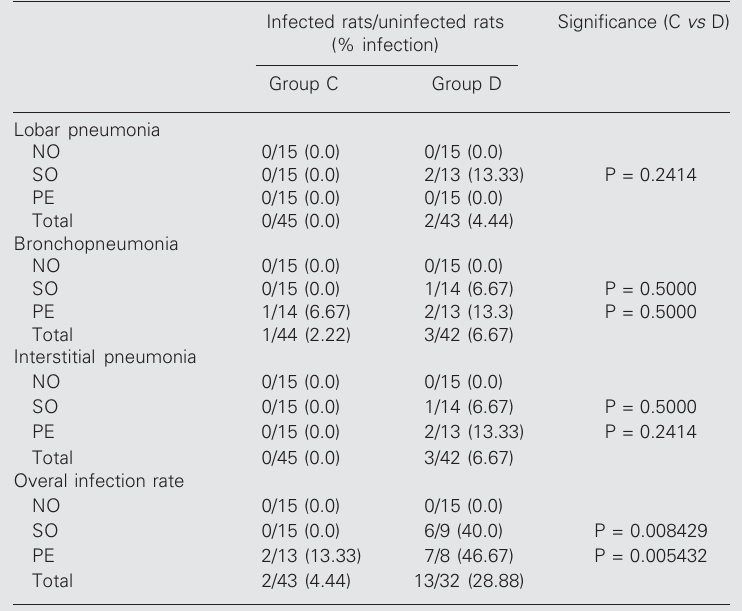
Table 2. Presence or absence of lobar pneumonia, bronchopneumonia, interstitial pneu- monia and overall infection rate in diabetic (group D) and nondiabetic (group C) rats. Infected rats/uninfected